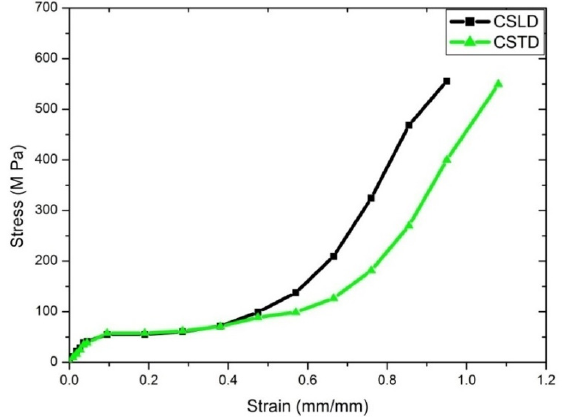
Figure 11. Compression stress–strain curve for dry condition.